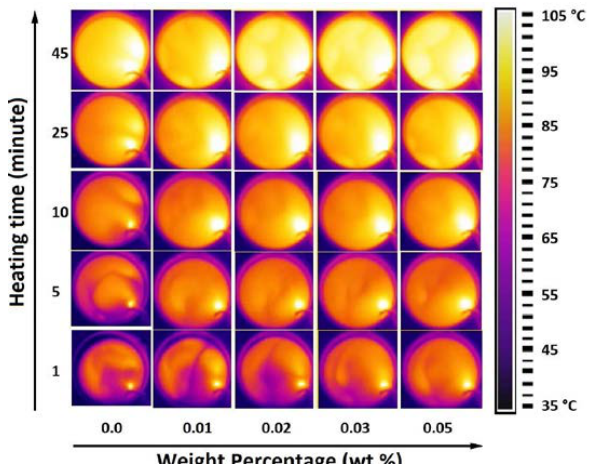
Figure10. Figure 10. Thermogram analysis of GO-based CSO nanofluids with heating time against weight percentage.